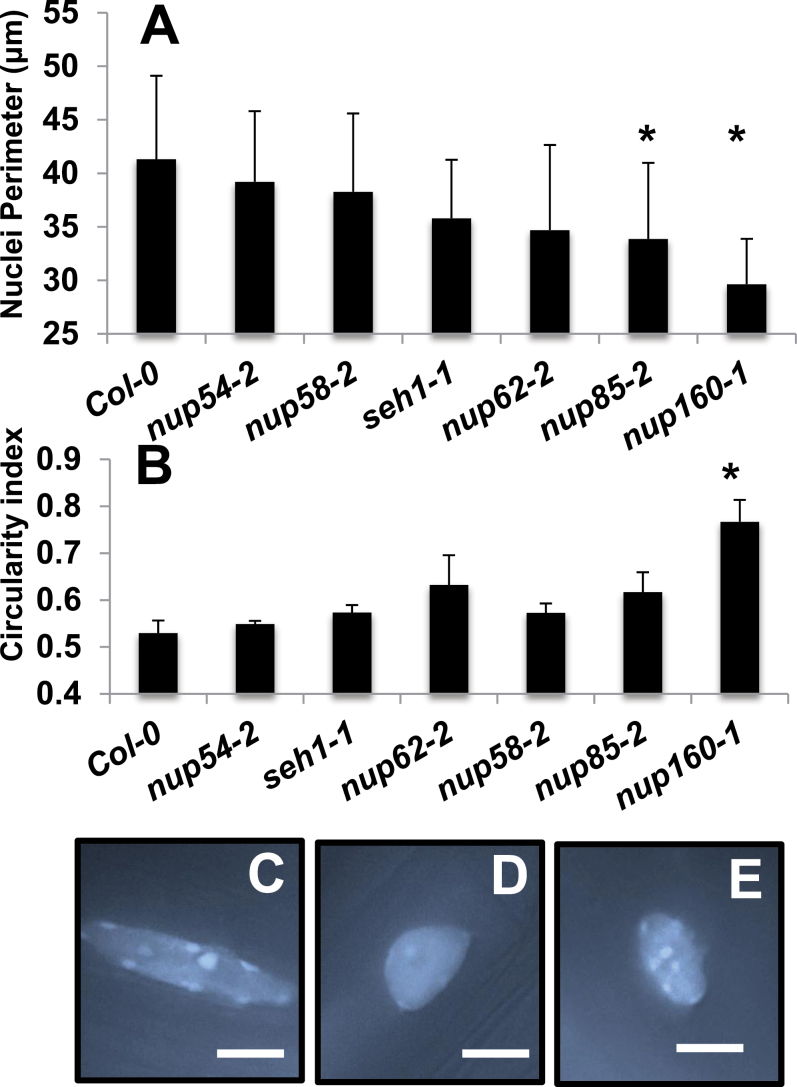
Nuclear morphology is altered in nucleoporin mutants. Nuclei perimeter size (A) or circularity (B) were measured from mature root cells of 7-day-old seedlings. In (B), a lower value represents less circular nuclei. Bars represent the SE from three independent experiments, with at least 29 nuclei per genotype. Average Student t-test values of original values compared with Col-0, P<0.01(*). Representative pictures of nuclei from Col-0 (C), nup160-1 (D), or sun1sun2KD (E; Zhou et al., 2012) root cells. The average circularity of sun1sun2KD nuclei is 0.66, n=47. Nuclei are stained using vectastain+DAPI (1.5 μg ml–1). Scale bar=10 μm.